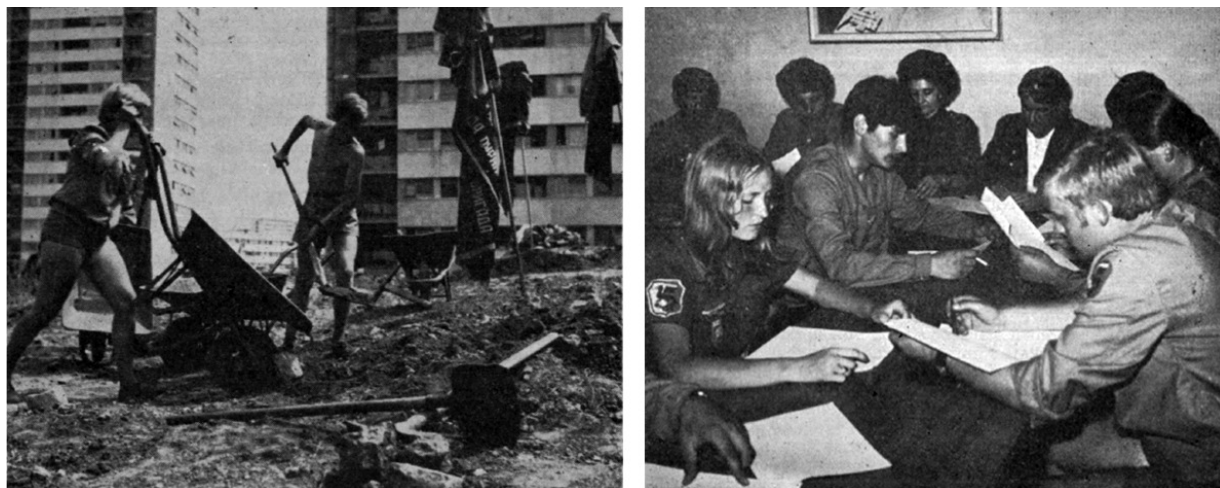
Figure 5. Constructing New Belgrade two decades on (1968, left) and New Belgrade‐69 self‐management (planning the work actions, 1969, right). Source: Stefanovic (1969, pp. 57 [left], 64